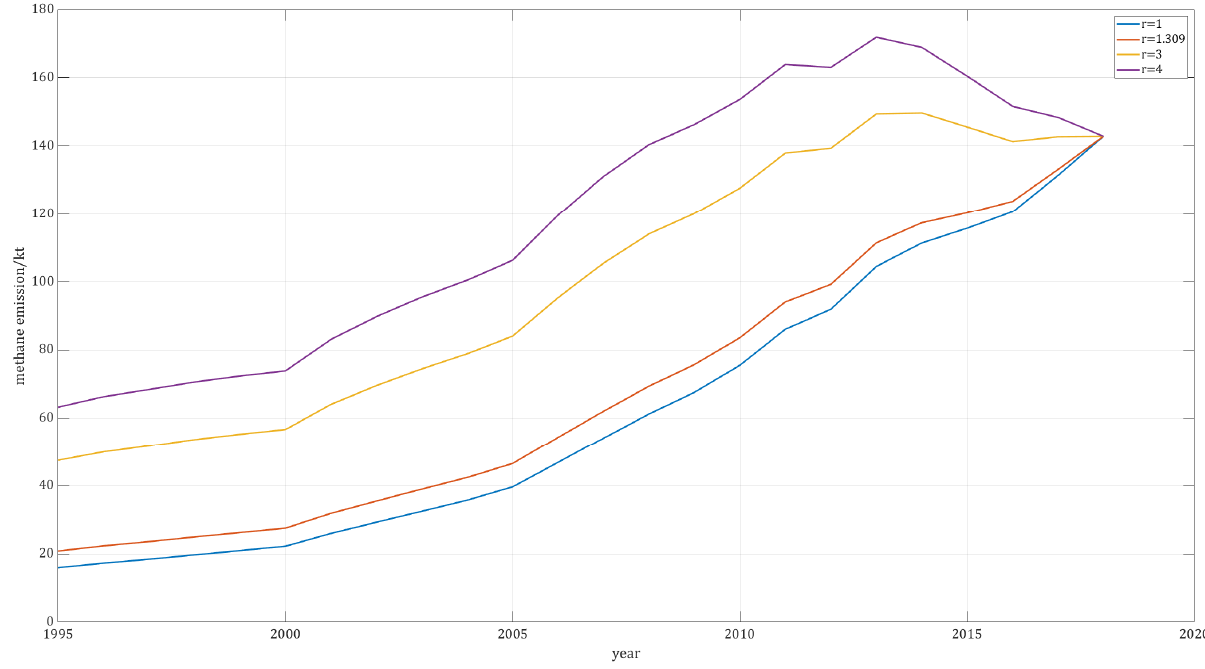
Figure 8. The impact of technology development parameter r .